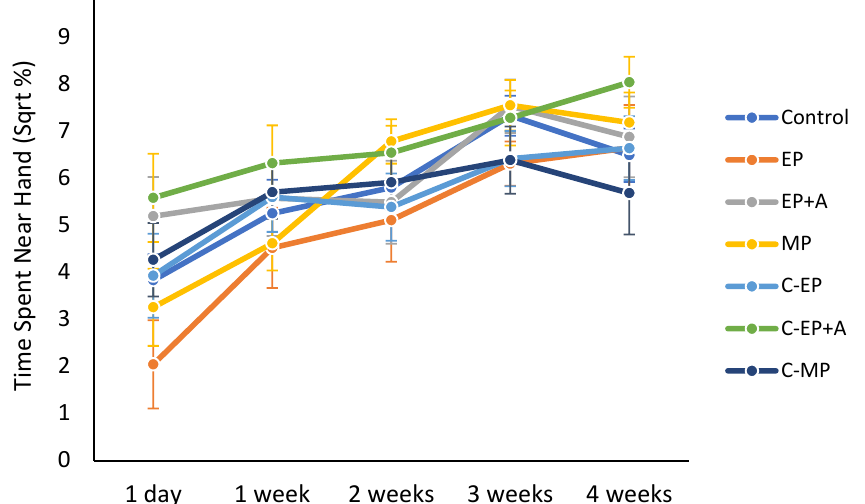
Figure 5. Effects of identification marking of mice on voluntary interaction with the handler’s hand.